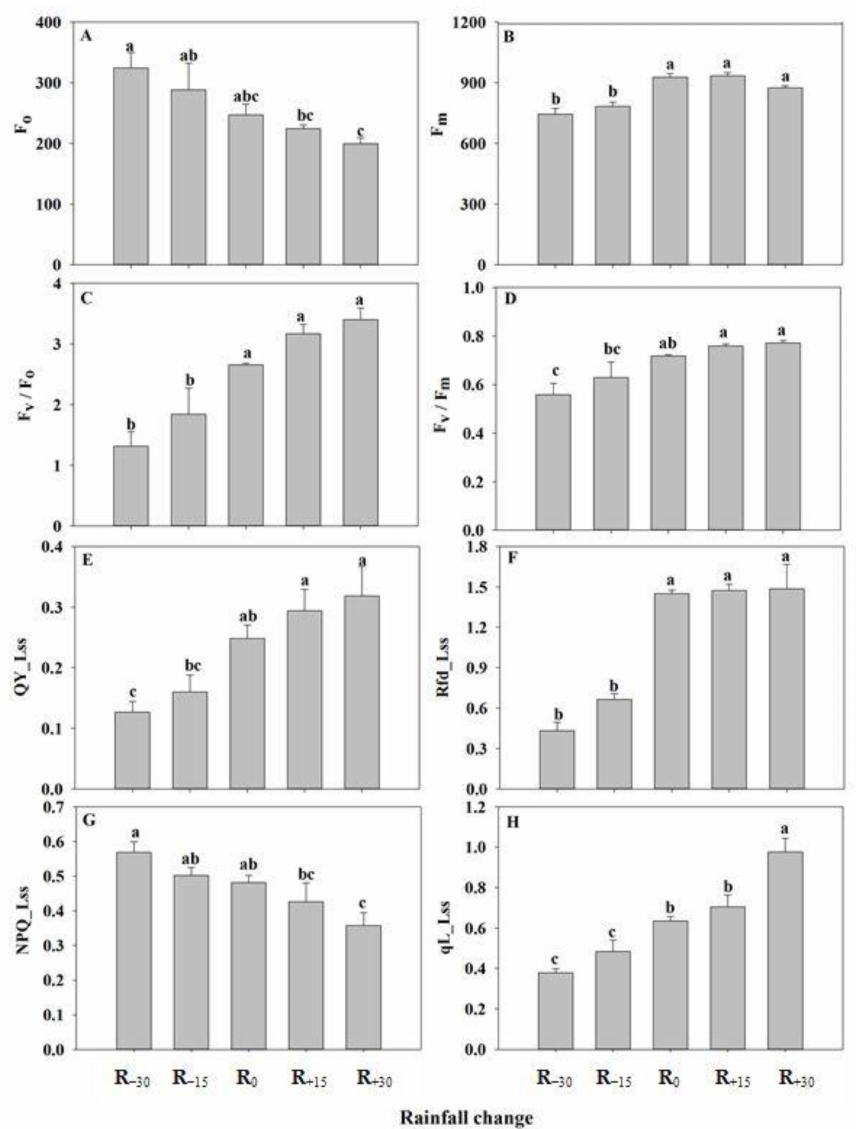
Figure 4. Changes in chlorophyll fluorescence parameters in Gymnocarpos przewalskii leaves under rainfall change. ( A ): F o ; ( B ): F m ; ( C ): F v /F o ; ( D ): F v /F m ; ( E ): QY_Lss; ( F ): Rfd_Lss; ( G ): NPQ_Lss; ( H ): qL_Lss; F o , initial fluorescence; F m , maximum fluorescence; F v /F o , potential activity of PSII; F v /F m , maximum quantum yield of PSII; QY_Lss, steady state optical quantum efficiency; Rfd_Lss, steady state fluorescence decay rate; NPQ_Lss, steady state non-photochemical quenching coefficient; qL_Lss, steady state photochemical quenching coefficient; R 0 , mean monthly rainfall from May to August during the period from 1961 to 2018; R − 30 , R 0 decreased by 30%; R − 15 , R 0 decreased by 15%; R +15 , R 0 increased by 15%; R +30 , R 0 increased by 30%. Vertical bars represent the means ± SE (n =